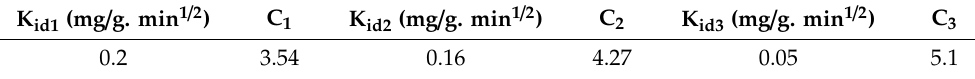
Table 4. Parameters for intra-particle diffusion model.